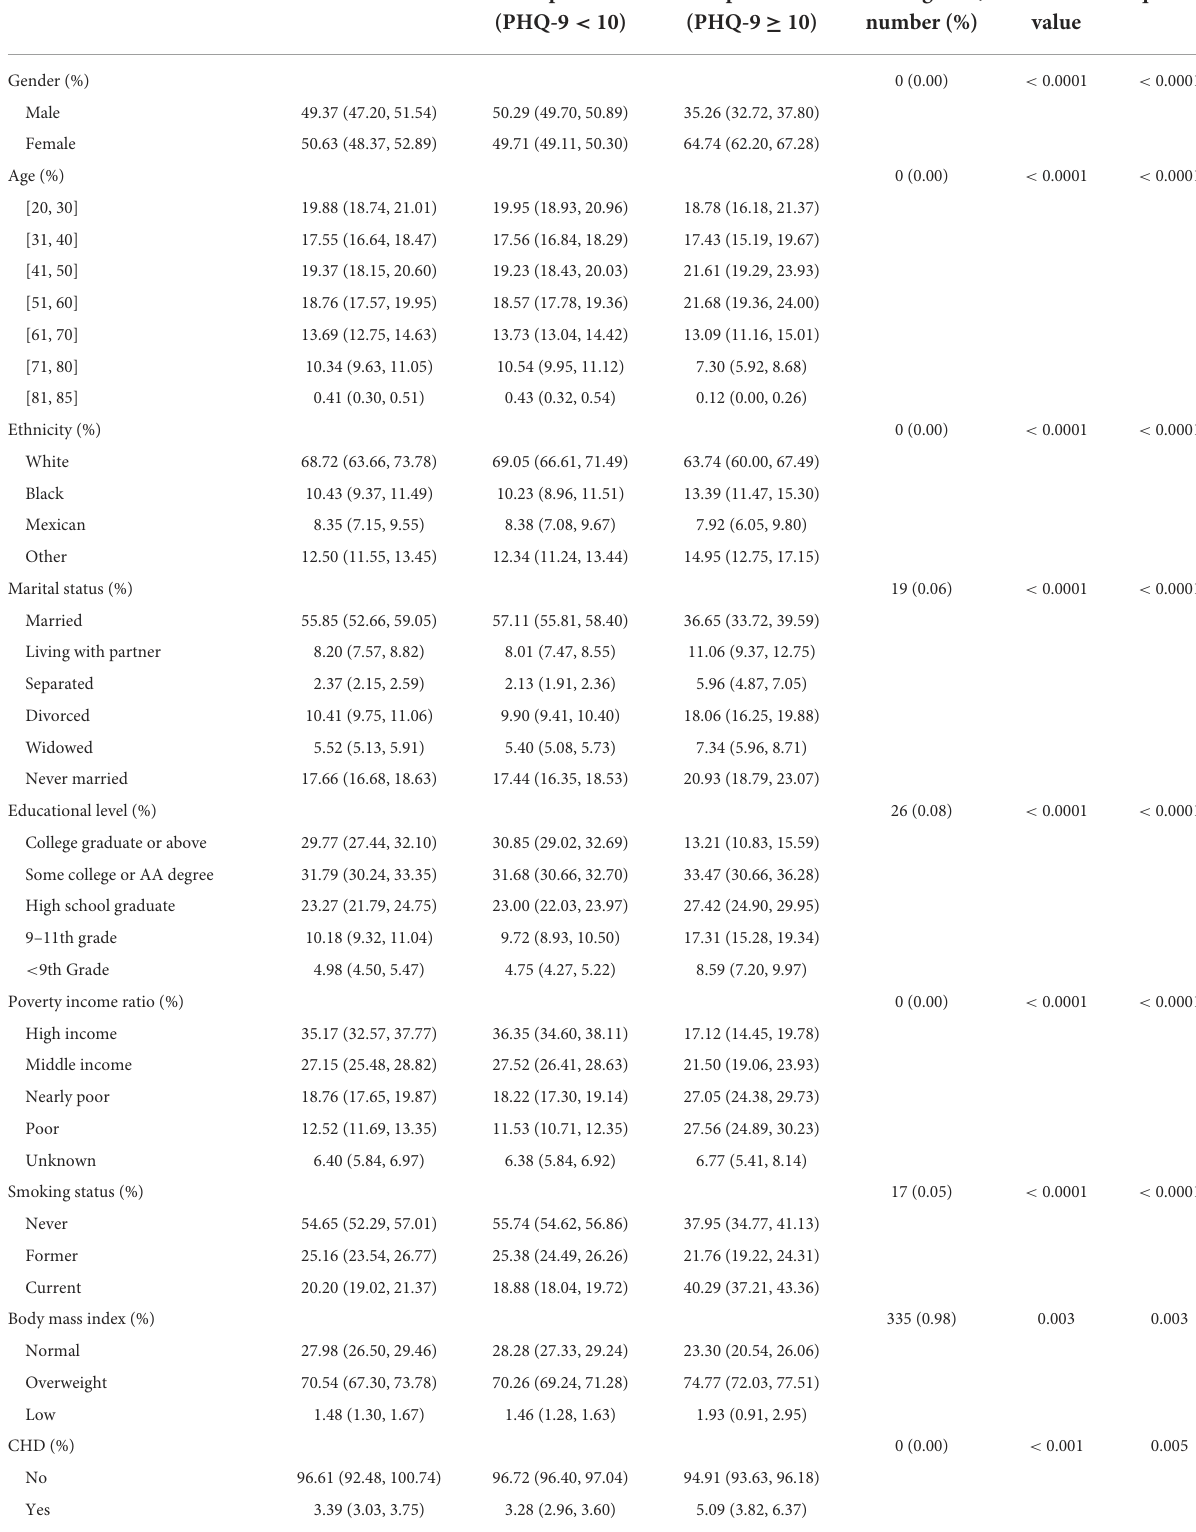
TABLE 1 Baseline characteristics of study participants a